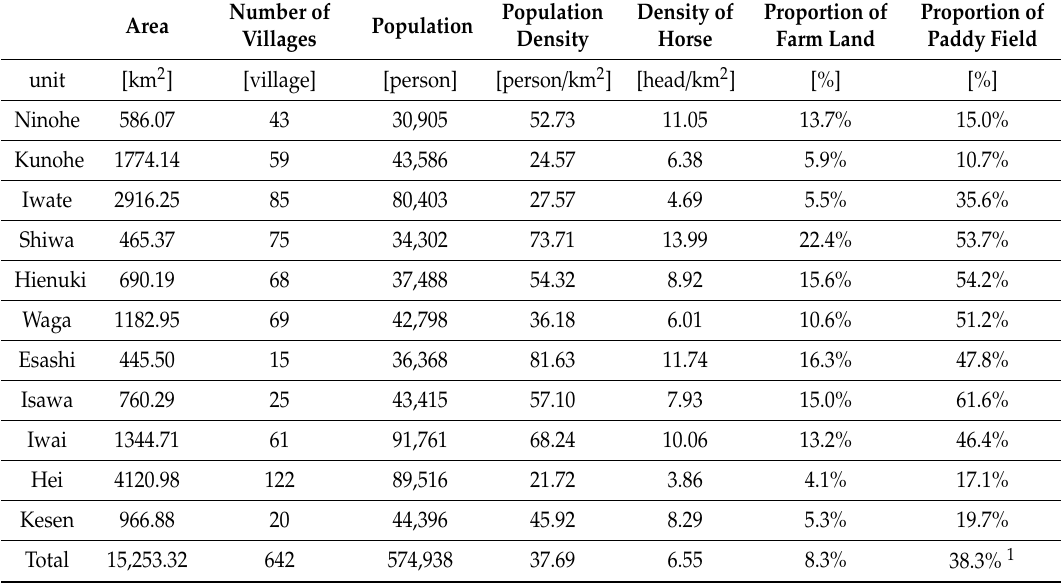
Table 3. Specifications of each county of Iwate